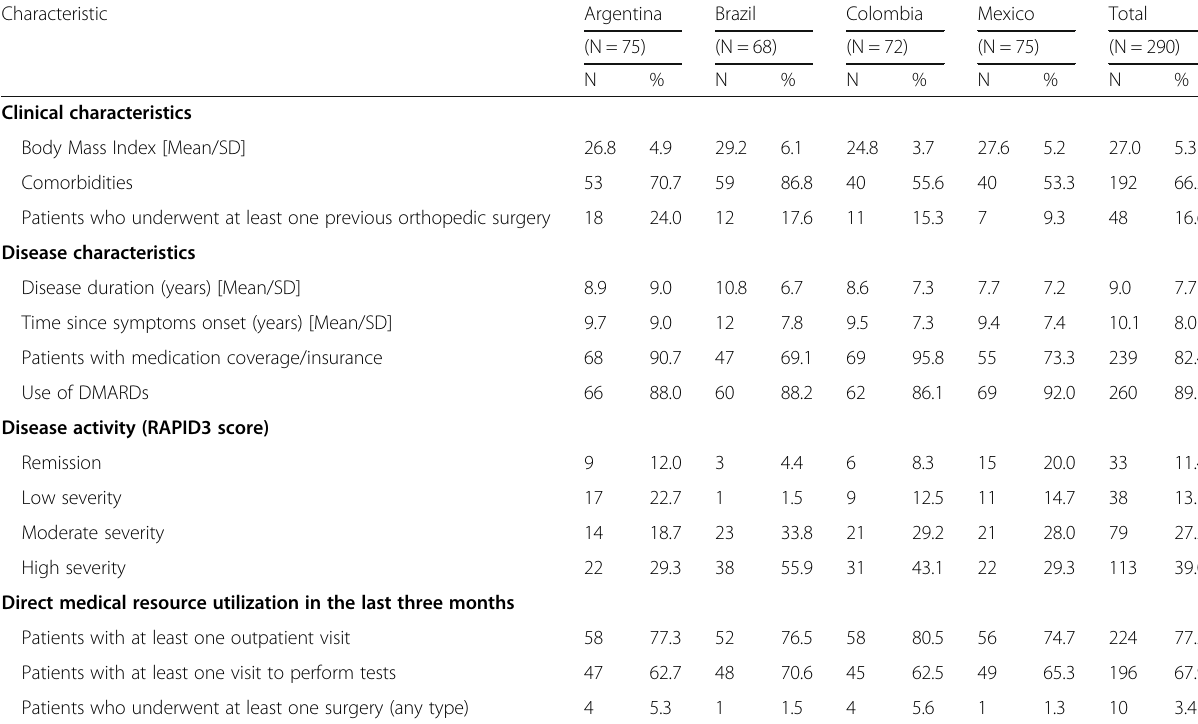
Table 2 Description of studied clinical characteristics among RA patients at baseline